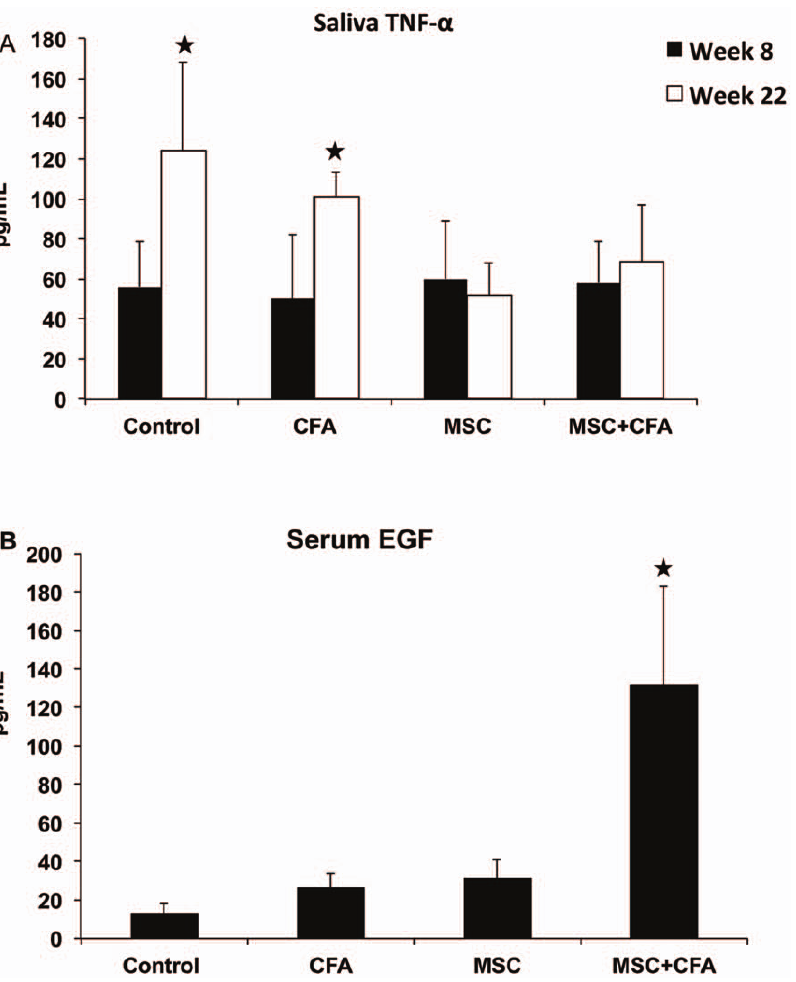
Figure 4. Measurements of TNF a and EGF concentrations in saliva and serum. Upper panel (A) , as expected, the level of TNF a in saliva was significantly higher (*P , 0.05) in non-treated NOD mice at week 22 (established Sjo¨gren’s-like disease) when compared to week 8 (before disease onset). At the end of the experimentation period (week 22), treated MSC and MSC + CFA mice had two times less TNF a levels than non-treated NOD (*P , 0.05). Lower panel (B) , concentrations of serum EGF was significantly higher in MSC + CFA group versus control, CFA, and MSC groups (n=4 to 8 mice per group; P , 0.05).